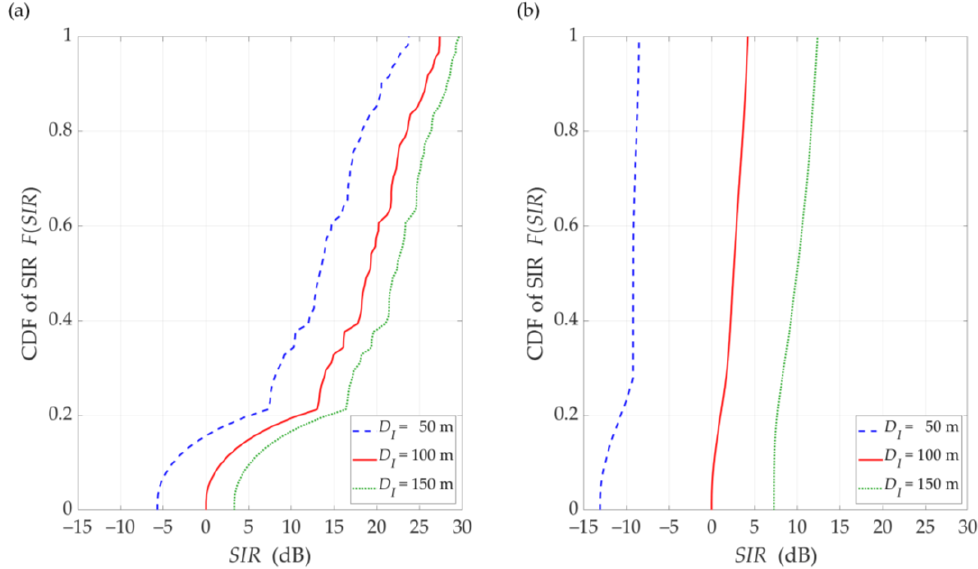
Figure 12. CDFs of SIR for UL scenario, selected D I = {50, 100, 150} m, D S = 100 m, ( a ) LOS (TDL-D) and ( b ) NLOS (TDL-B) conditions.